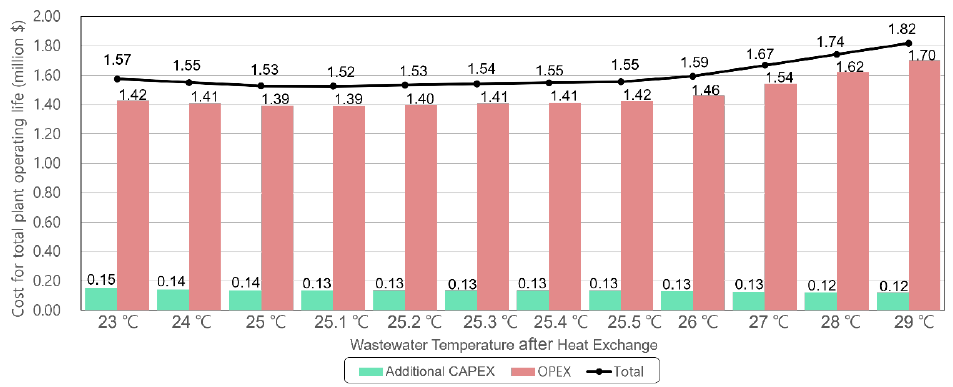
Figure 8. Economic analysis of Case 2 at varying temperatures.